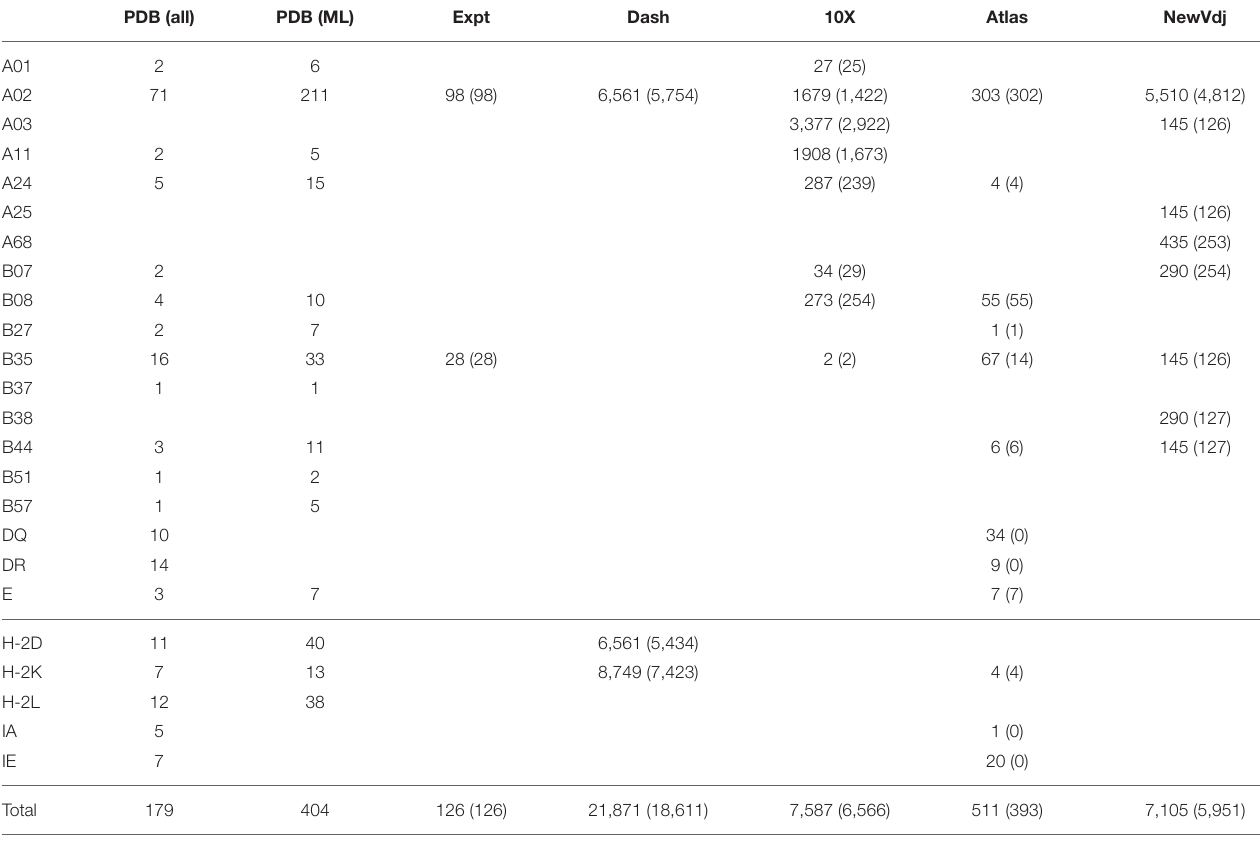
TABLE 1 | MHC associated with peptides in each